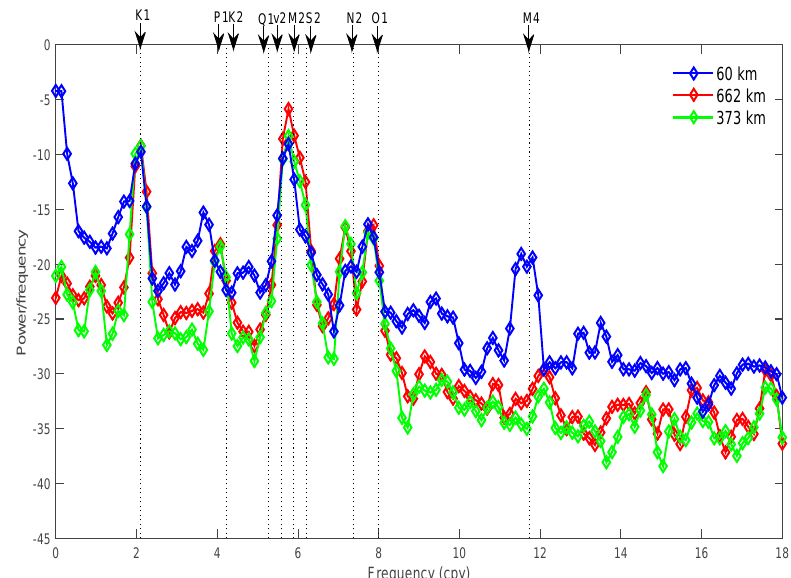
Figure 6. PSD of observed SLA along TOPEX-Jason ground track 251. Points are located at 149°8 ′ 35 ″ E, 19°44 ′ 52.80 ″ S (blue curve), 150°10 ′ 48.00 ″ E, 17°19 ′ 34.32 ″ S (red curve), and 151°8 ′ 32.00 ″ E, 14°53 ′ 46.00 ″ S (green curve) around 60 km, 373 km, and 662 km, respectively, from the coast. The aliasing period of the eight main tidal constituents (e.g., M 2 ) and major shallow-water tidal constituent (M 4 ) are shown by arrows.